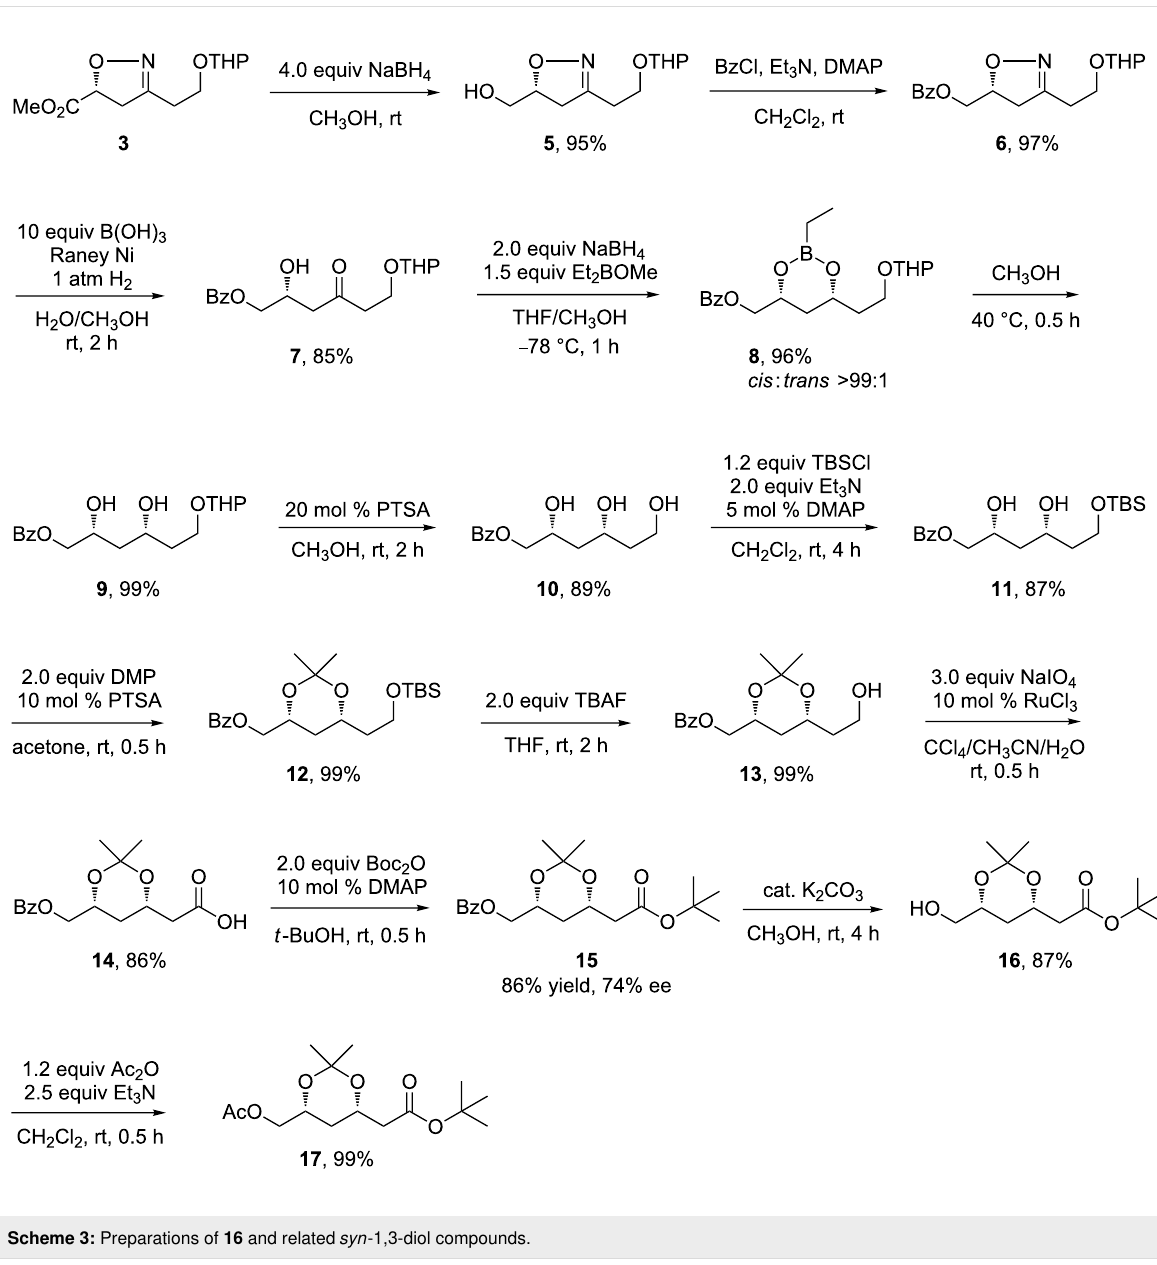
Scheme 3: Preparations of 16 and related syn -1,3-diol compounds.